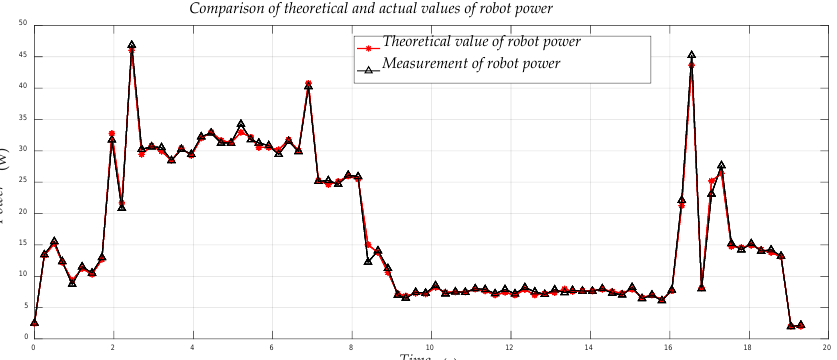
Figure 13. Comparison of power consumption values from multiple experimental measurements.